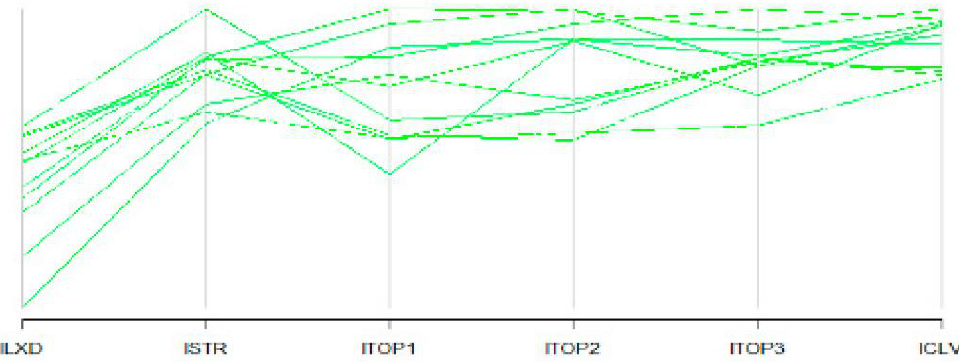
Figure 5. With the data in Figure 3, texts belong to the second quartile of l CLV, R package MASS.